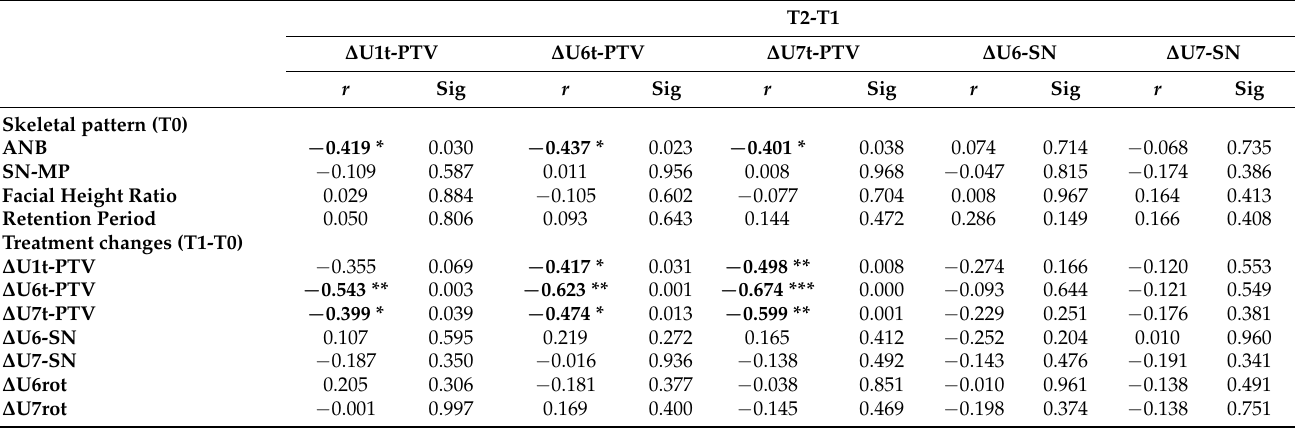
Table 6. Pearson’s correlation coefficients between post-treatment changes and other variables in the maxilla.